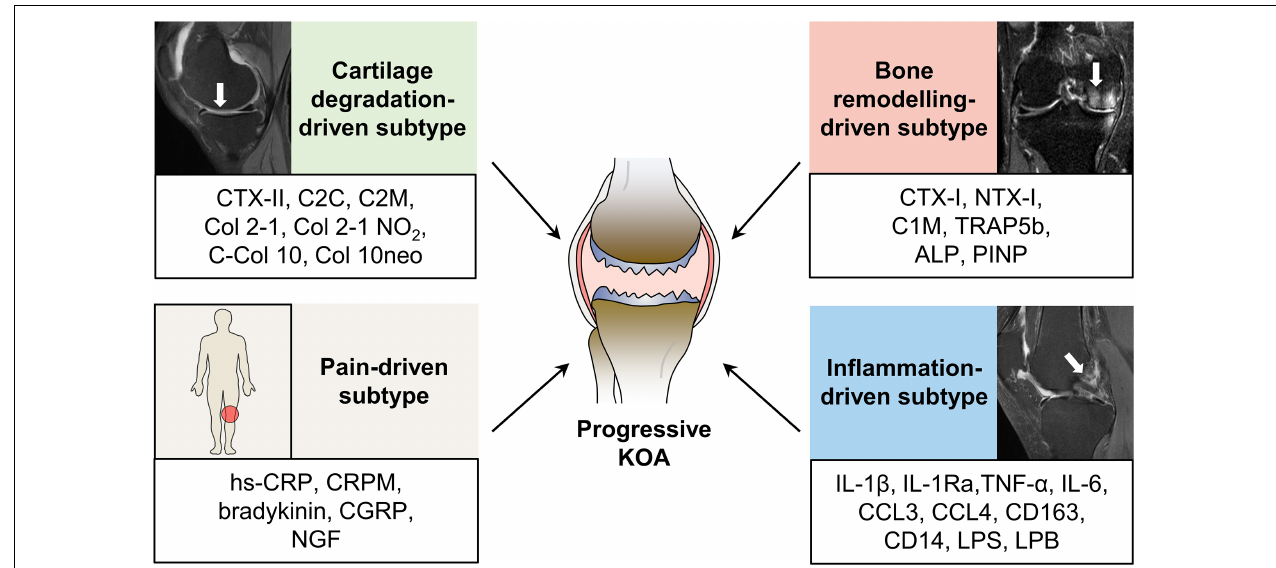
FIGURE 2 | Molecular subtypes of progressive KOA. Increasing evidence suggests that progressive KOA patients fall into several subtypes based on the identified molecular profiles, including cartilage degradation-driven subtype, bone remodeling-driven subtype, inflammation-driven subtype, and pain-driven subtype. Representative molecules are listed in the box bellow the MRI manifestation of each subtype. ALP, alkaline phosphatase; CCL3, CC-chemokine ligand 3; CCL4, CC-chemokine ligand 4; Col 2-1 NO 2 , the nitrated form of Col 2-1; C-Col 10, C-terminus of collagen X; Col 10neo, a neoepitope of collagen 10; CGRP, calcitonin gene-related peptide; CRPM, the fragment of C-reactive protein; CTX-I, C-telopeptide of Col-I; CTX-II, C-telopeptide fragments of Col-II; C2C, the cleavage neoepitope of collagen II; C1M, the product of collagen I degraded by matrix metalloproteinases; C2M, the fragments of collagen II degraded by matrix metalloproteinases; hs-CRP, high sensitive C-reactive protein; IL-1 β , interleukin 1 β ; IL-1Ra, IL-1 receptor antagonist; IL-6, interleukin 6; KOA, knee osteoarthritis; LPS, lipopolysaccharide; LPB, LPS binding protein; MRI, magnetic resonance imaging; NGF, nerve growth factor; NTX-I, N-telopeptide of Collagen I; PINP,